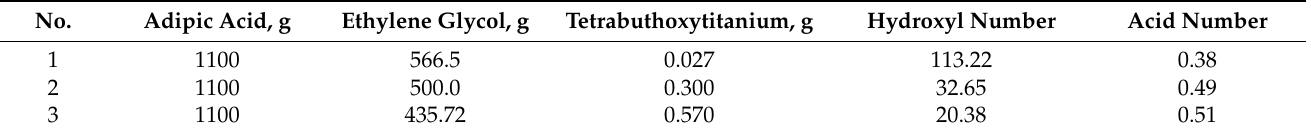
Table 1. Composition of polyester oligodiol.